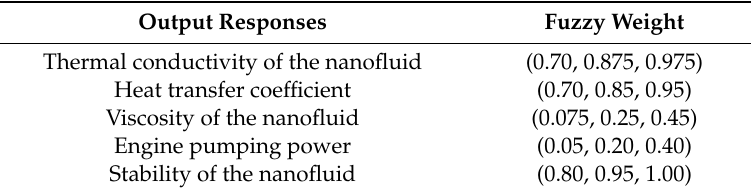
Table 8. Fuzzy weights.